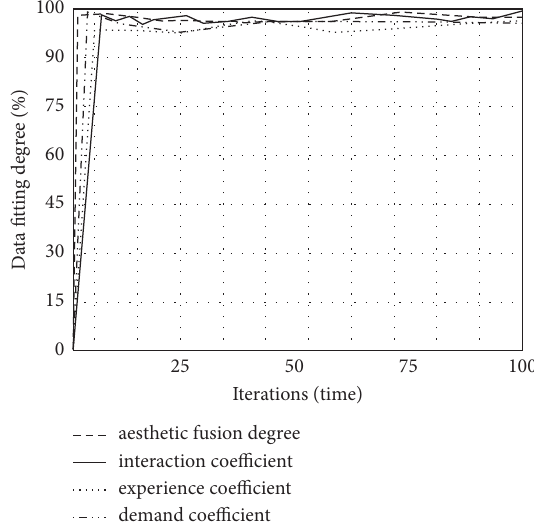
Figure 2: Product data processing